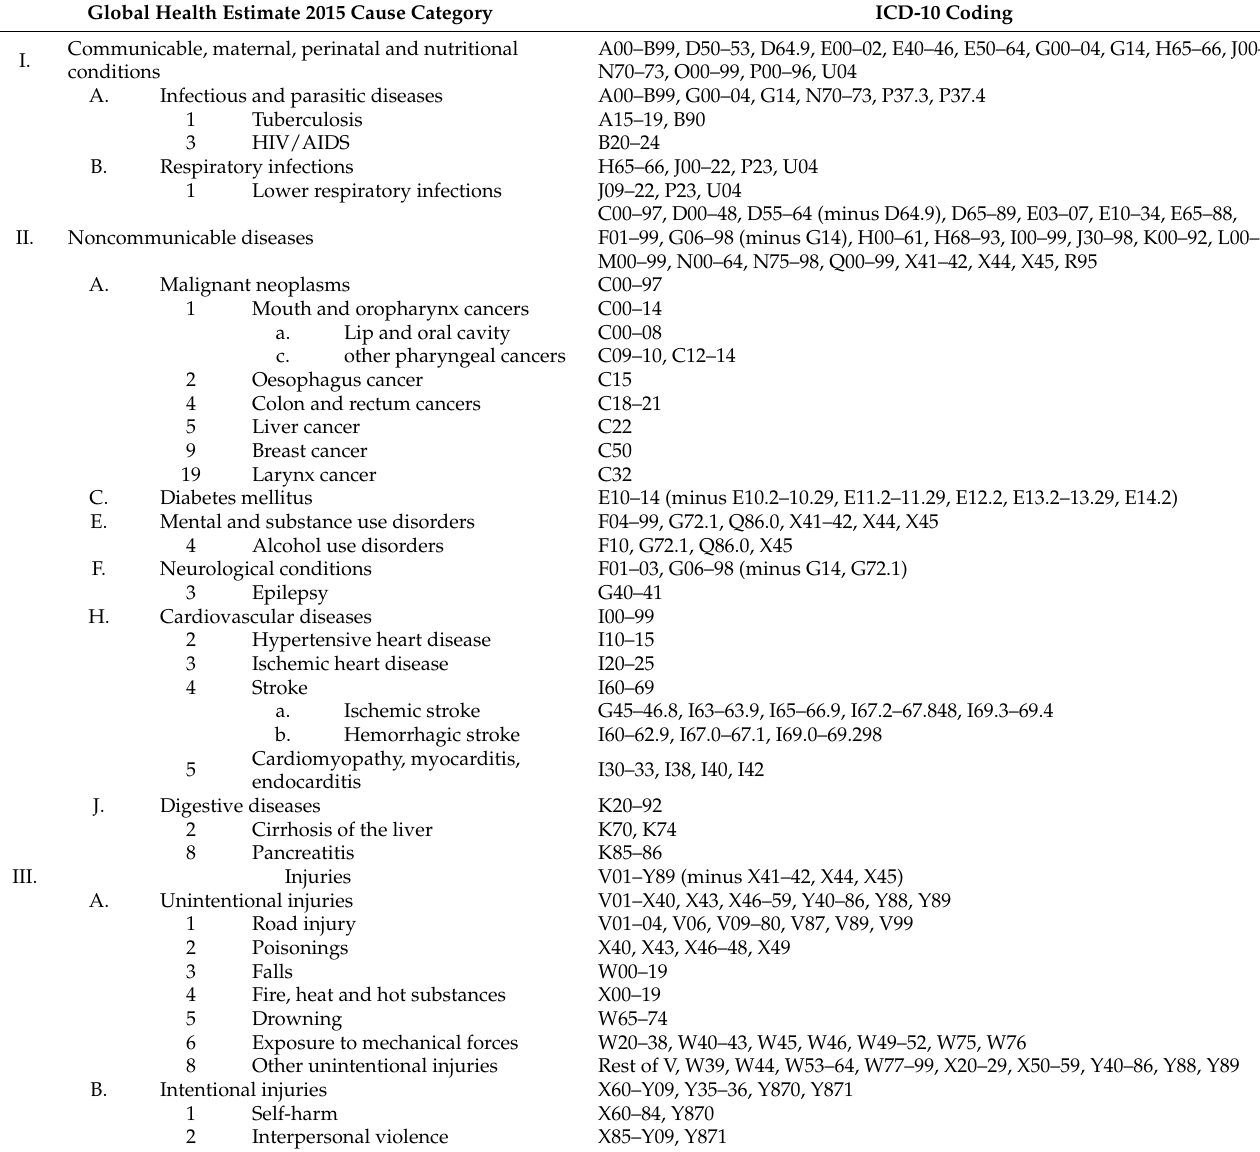
Table 1. Major disease categories causally related to alcohol and modelled in the last comparative risk assessments based on WHO data [8], and their codes in the International Statistical Classification of Diseases and Related Health Problems (ICD). Global Health Estimate 2015 Cause Category ICD-10 Coding